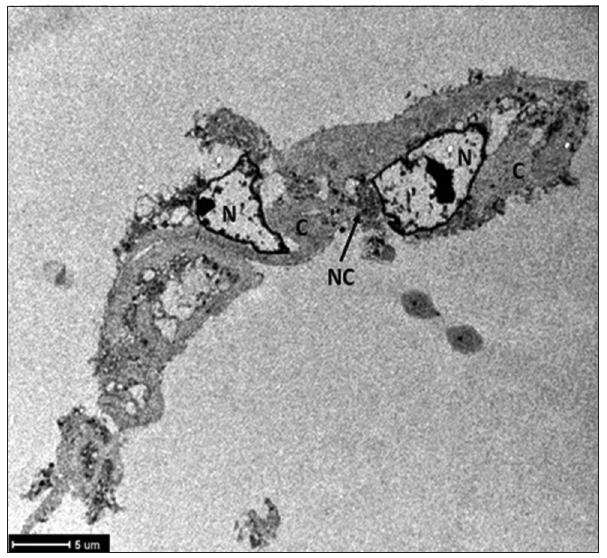
Figure-1: Transmission electron microscopy of adipose stem cell infected with canine distemper virus. N=Nucleus, C=Cytoplasmic matrix, NC=Viral nucleocapsid.